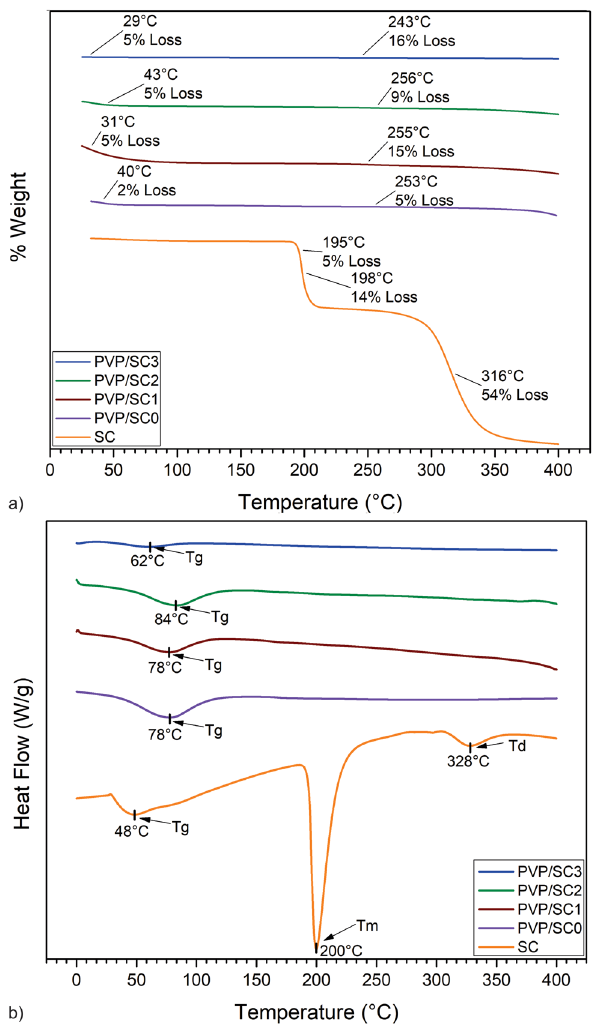
Figure 5: Thermal analysis of PVP/SC fi bers. ( a ) TGA; ( b )